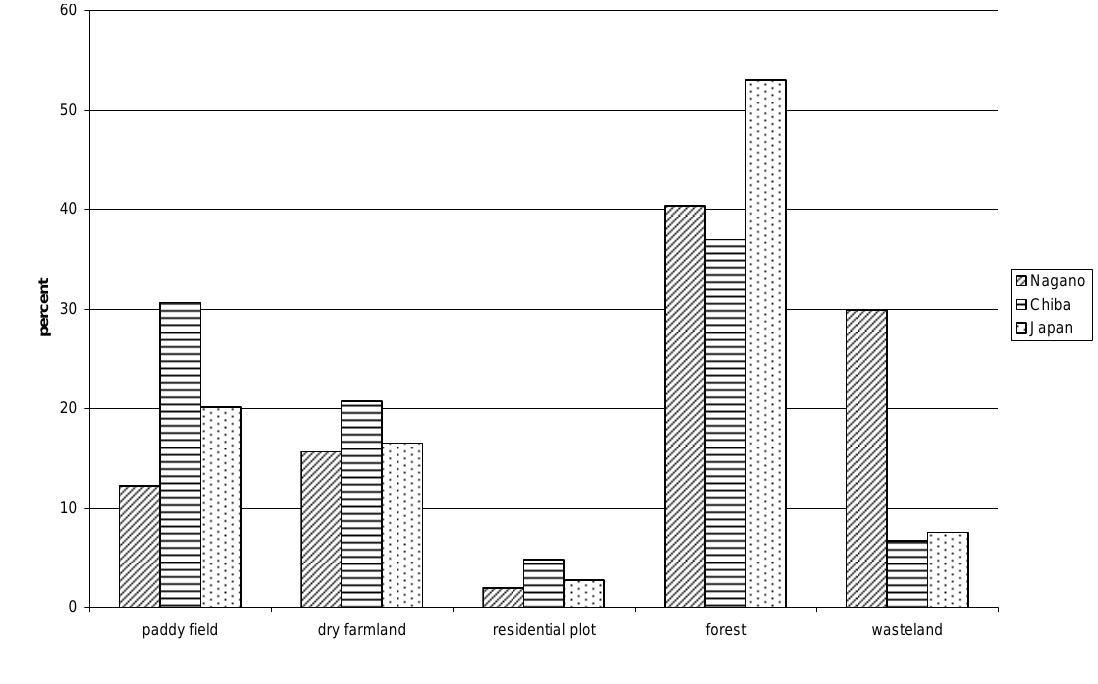
Figure 7. Private Land Usage in Nagano, Chiba and Japan,